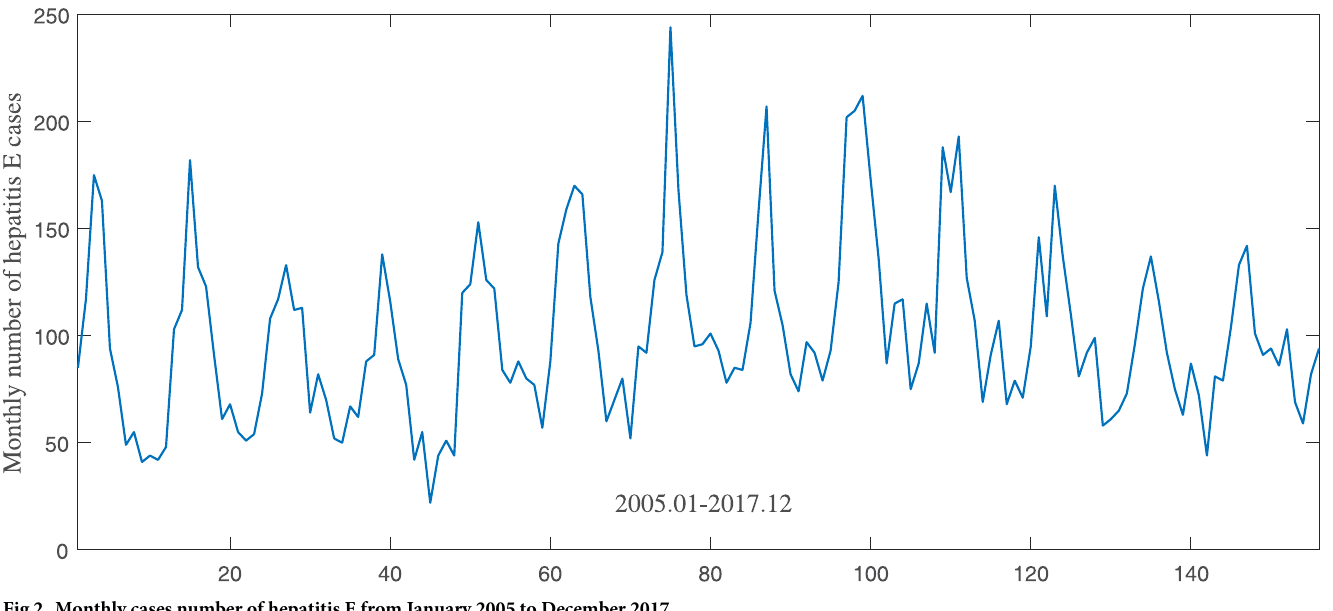
Fig 2. Monthly cases number of hepatitis E from January 2005 to December